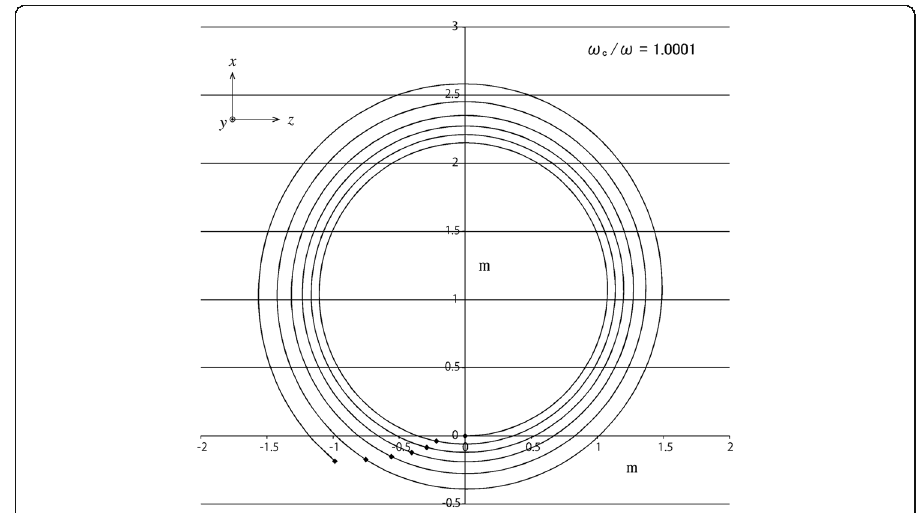
Fig. 3 The gyration orbit of a relativistic electron based on Eqs. (20) and (21). The initial velocity ^ z z 0 ¼ ^ z 10 8 m/s at ( t =0), E ( t ) = − ^ z 10 3 cos ω t V = m, ω c ¼ q j ^ y B jð 1 − z 2 t = 0~6 (2 π / ω c ) sec. An electron rotates about six times. The dots mark each time increment of 2 figure is related with Fig. 1a